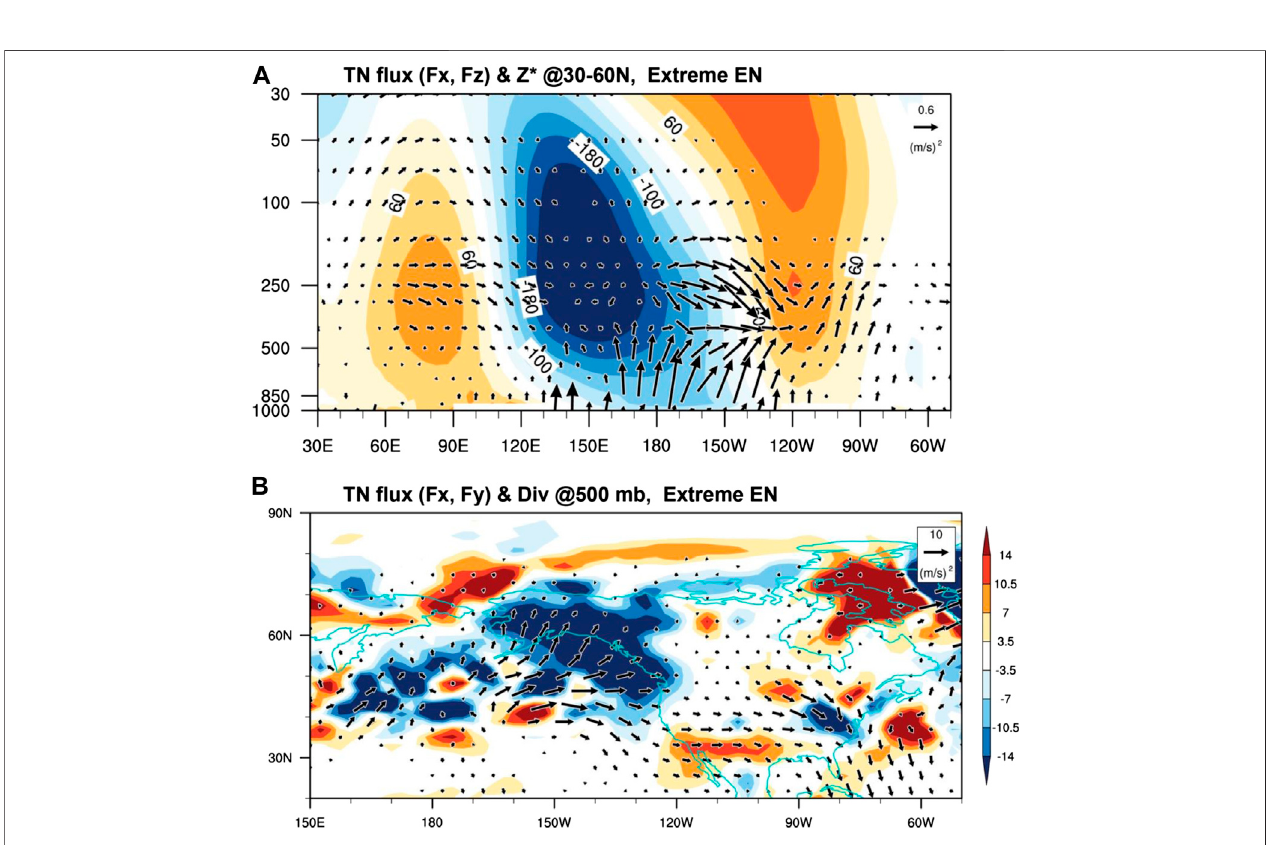
FIGURE5|(A) Height – longitudecross-sectionofthewave fl ux(F x ,F z ;vectors)andeddygeopotentialheight(Z*;color;m)averagedover30 ° – 60 ° Nduringextreme EN. (B) 500-hPa horizontal wave-activity fl ux (F x , F y ) (vectors; m 2 s − 2 ) and its divergence (color shading; 10 − 5 m 2 s − 2 ) for extreme EN. The wave fl ux is multiplied by the square root of 1000/pressure (hPa) to better indicate waves in the stratosphere. Figure for the moderate EN case with no obvious response were omitted.